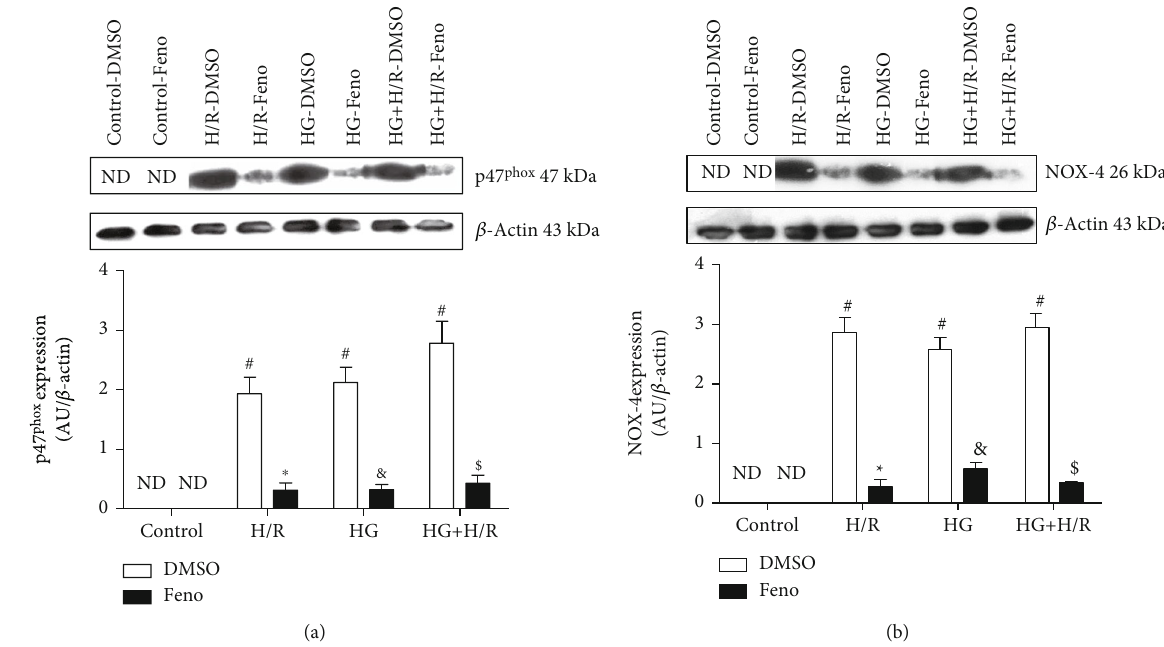
Figure 6: Feno fi brate (10 μ M) decreased the expression of the NADPH oxidase subunits in primary cultures of cardiomyocytes undergoing hypoxia/reperfusion (H/R), high glucose (HG), and the combination of both conditions (HG+H/R). (a) Protein expression and densitometric analysis of the p47phox subunit expression. (b) Protein expression and densitometric analysis of the NOX4 subunit expression. ND = not detectable; DMSO = dimethylsulfoxide (0.1%); Feno = feno fi brate (10 μ M). # p < 0 : 05 vs. control-DMSO; ∗ p < 0 : 05 vs. H/R-DMSO; & p < 0 : 05 vs. HG-DMSO; $ p < 0 : 05 vs. HG+H/R-DMSO. Values represent the mean ± SEM of 6 di ff erent experiments. Two-way analysis of variance (ANOVA) followed by Tukey ’ s post hoc